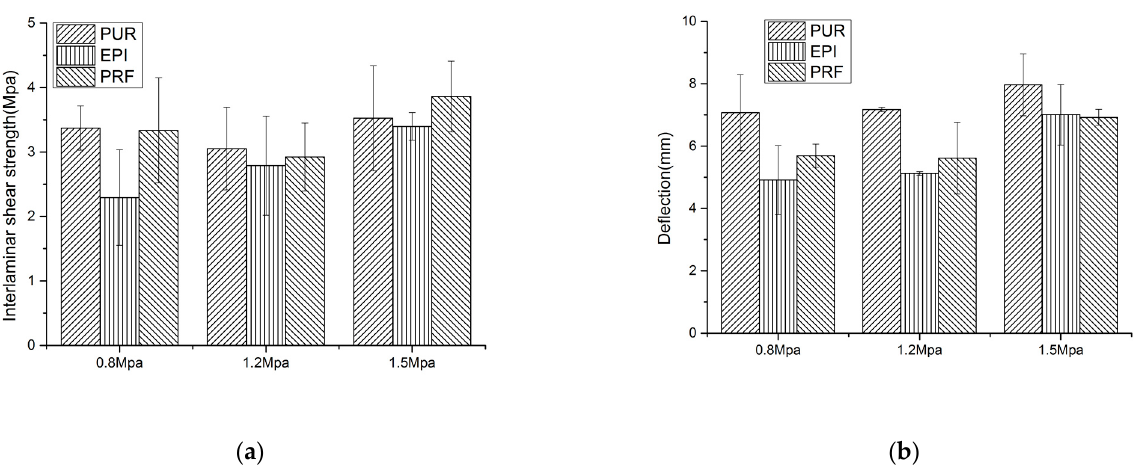
Figure 3. Mechanical properties of CLT under short span center-point bending test(a. interlaminar shear strength; b. Deflection ).